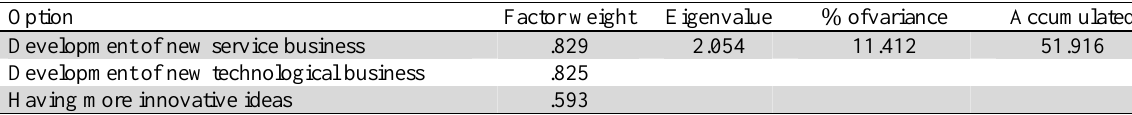
The summary of factors associated with consumer materialism Option Factor weight Eigenvalue % ofvariance